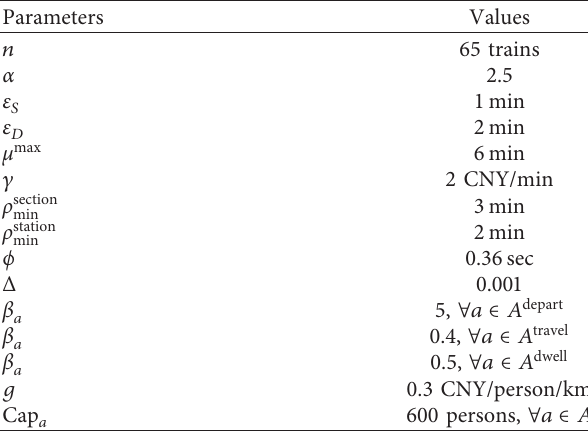
Table 3: The values of other input parameters. Parameters Values